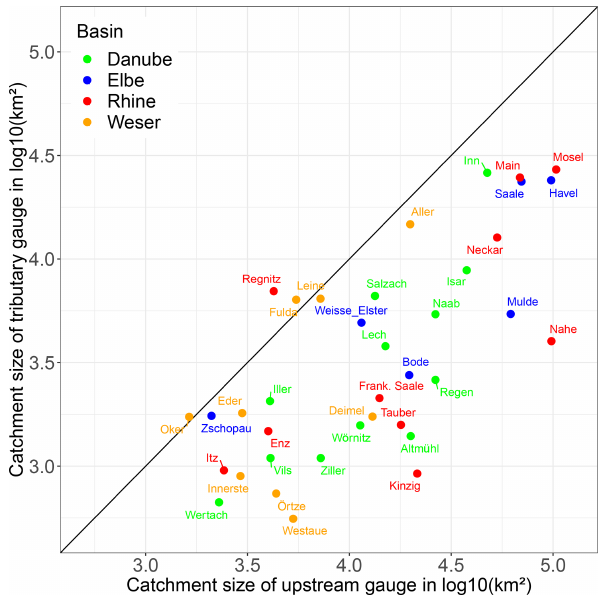
Figure 2. For each triple point, the catchment size of the upstream and tributary gauge is shown on a log scale. The tributary name is coloured according to the major river